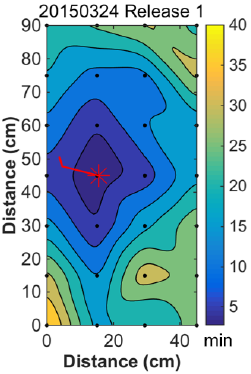
Figure 9. Plot of the time required for CO to reach maximum con- centration for a release with snow pickets placed below an ice layer. The red wind barb indicates the average wind speed (in knots) and direction during the measurement period (see also Table 1). The distance is relative to the bottom and leftmost sensor relative to a coordinate plane viewed from above. The plume has a molecular diffusion signature (roundish), a wind direction signature (down- wind propagation) but is also characterized by flow along preferred pathways, which render as irregular lobes at the sensor network res-